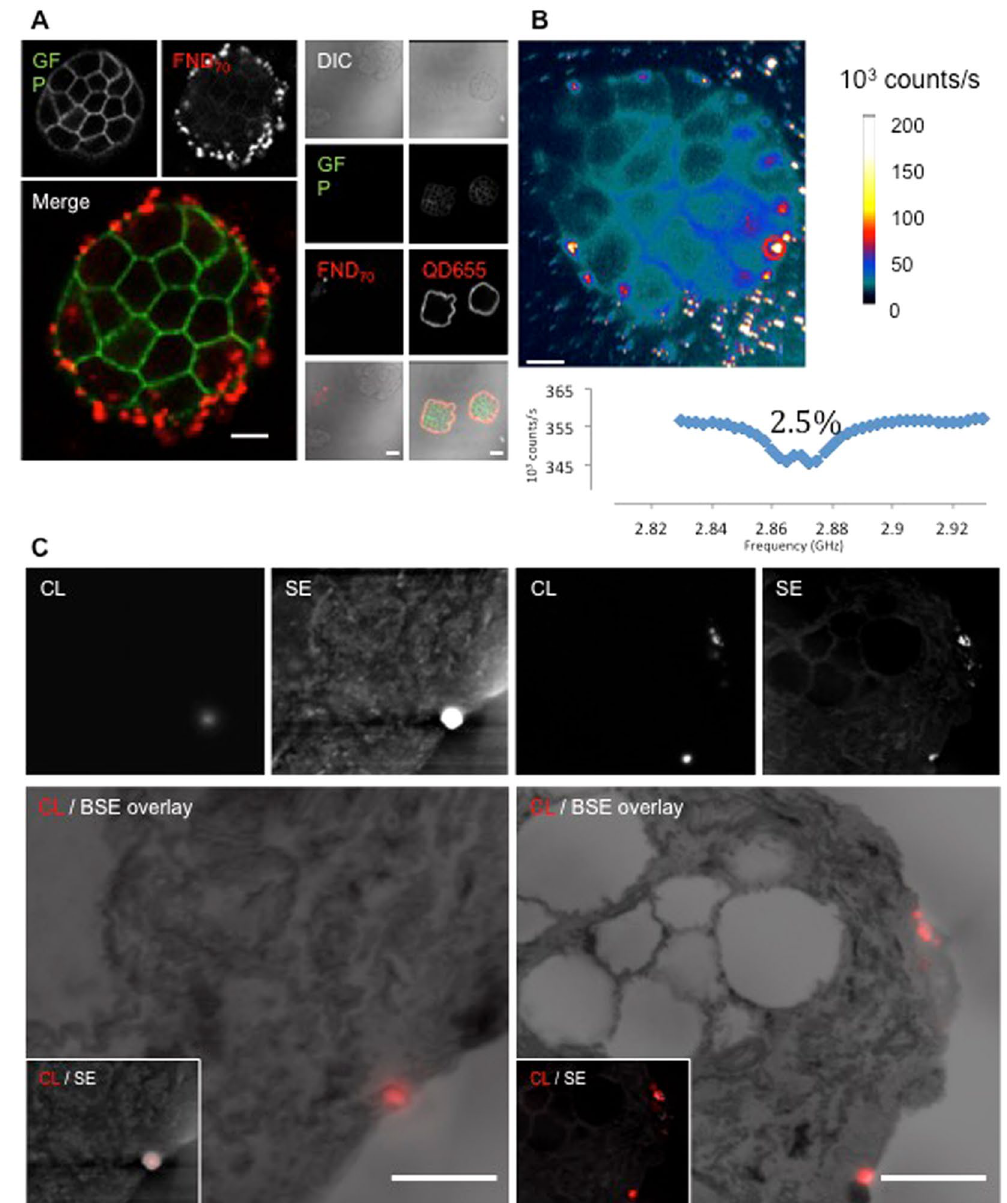
Figure 4. Multimodal analysis of FND70 immunolabeling of EpCAM-GFP HT29 cells. ( A ) Streptavidin- conjugated FND70 labels at the outside of a HT29 cell cluster. The context of different cells within the cluster is shown by GFP. Negative controls (left column) and positive controls (right column; QD655) are shown. No FND70 labeling of non-transfected negative controls is observed, context is shown by diffraction interference contrast (DIC) as EpCAM-GFP is absent. ( B ) Magnetic resonance spectra where taken at the bright spots identified as diamonds. The lower part of the figure shows the spectrum taken at the circled spot. 2,5% is the contrast between the resonance line and the background for 1 run. ( C ) CL, SE and the CL overlaid with BSE images of FND70 labeling an HT29 cell cluster at the cell surface. Note that in the right image single FND70 particles are resolved with CL. Abbreviations as in Fig. 3. Bars: ( A , B ) 25 μ m, ( C ) 1 μ